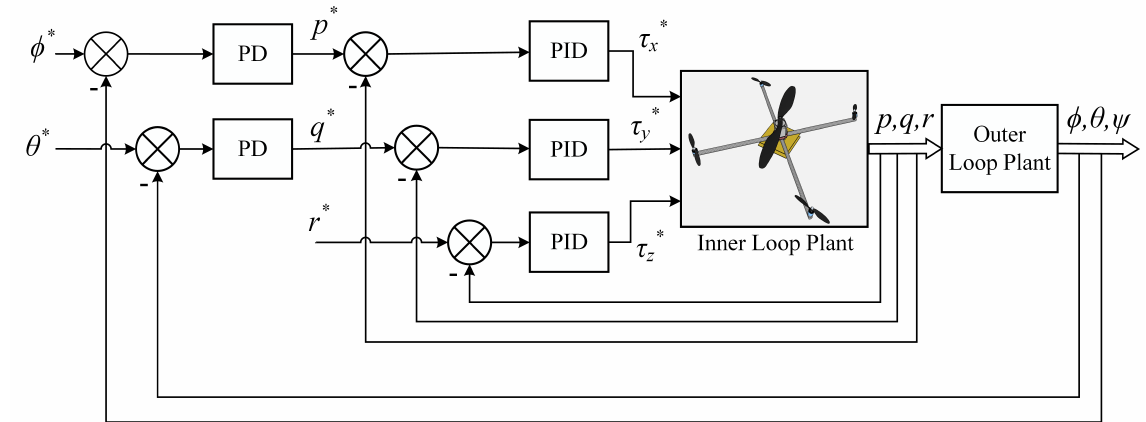
Figure 3. Cascade control structure for attitude control of heterogeneous multirotor.